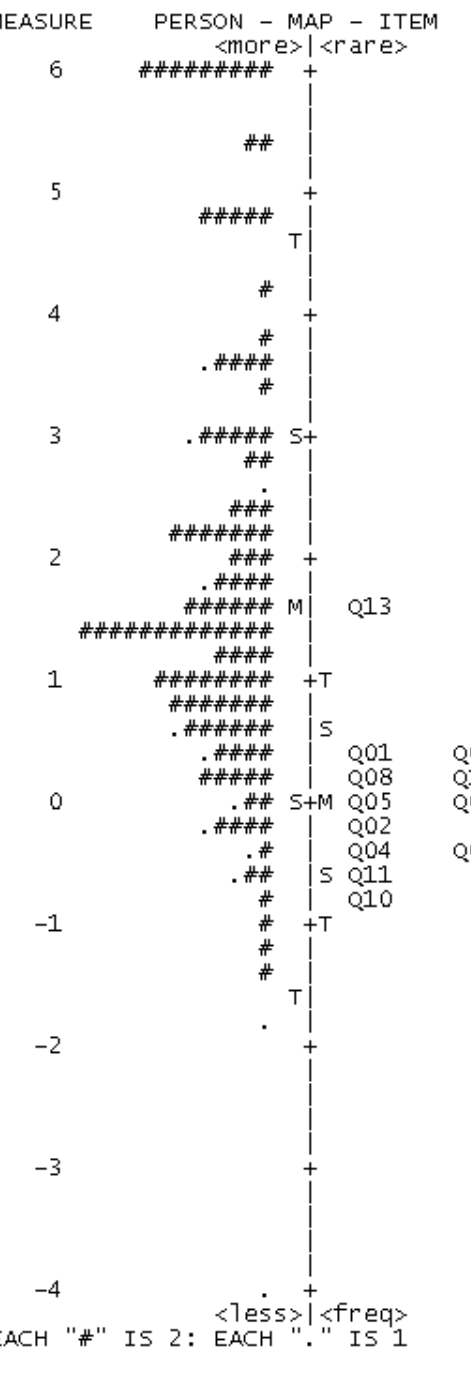
Figure 4 . Wright hierarchy